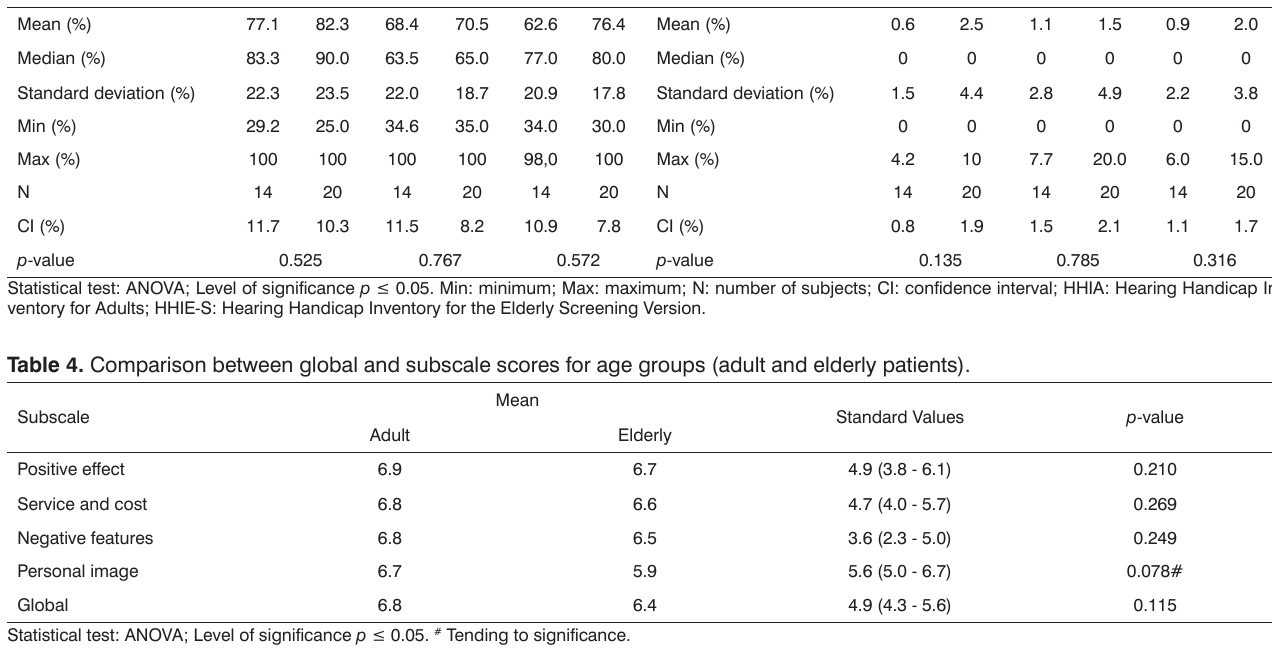
Table 3. Age group (adult and elderly patients) comparison of findings from HHIA and HHIE-S scales before and one month after hearing aid fitting. Social Emotional Global Social Emotional HHIA/HHIE after